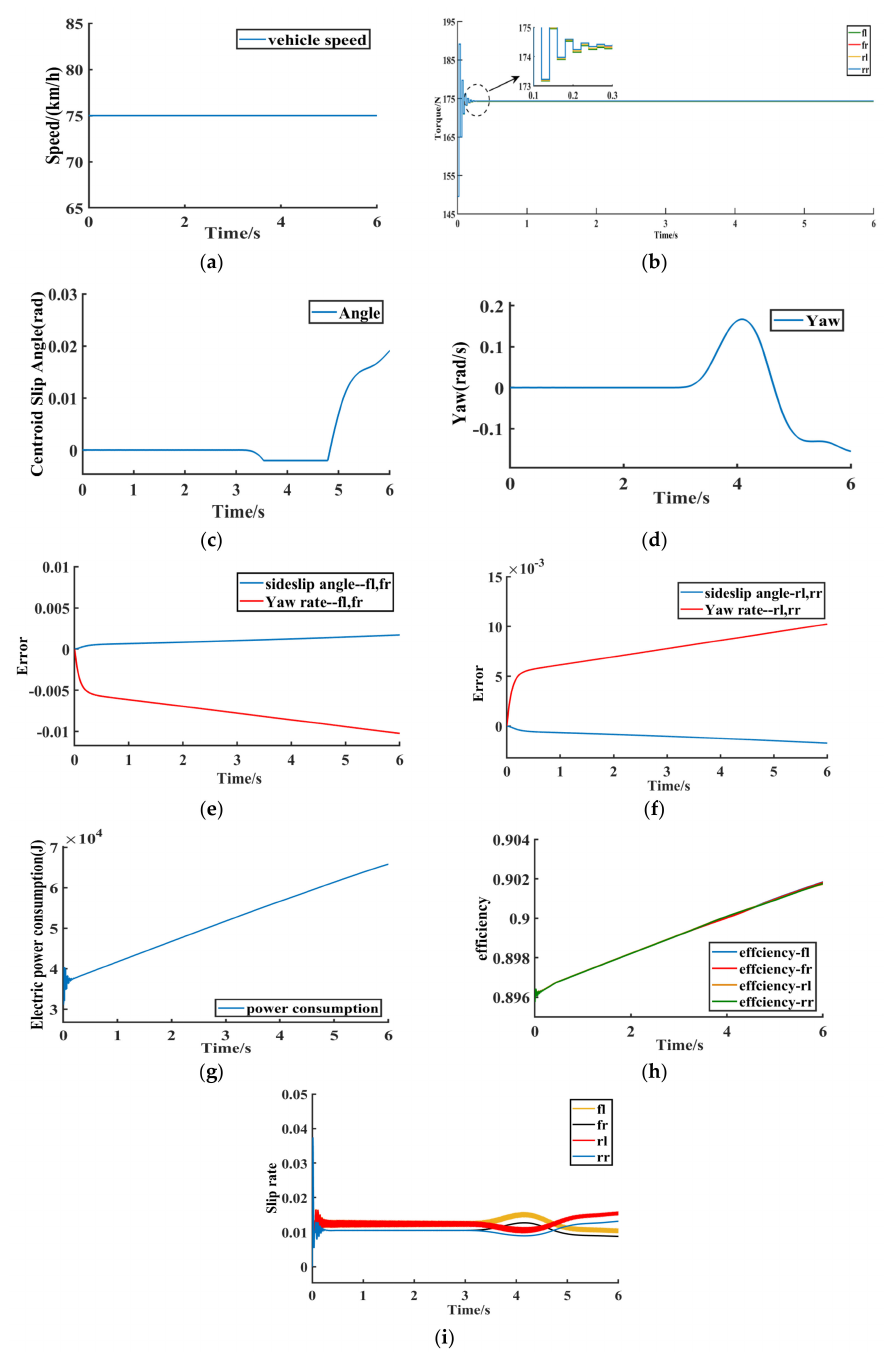
Figure 8. DLC. ( a ) Vehicle target speed. ( b ) In-wheel motor torque. ( c ) Vehicle sideslip angle. ( d ) Yaw rate. ( e ) fl, fr error. ( f ) rl, rr error. ( g ) Motor efficiency. ( h ) Electric power consumption. ( i ) Wheel slip